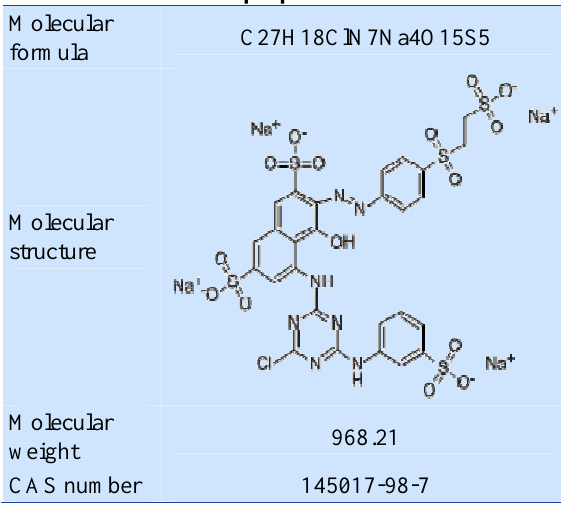
Table 1. The chemical properties of RR198